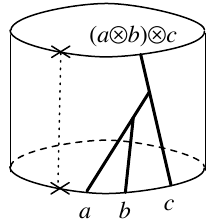
Figure 33 . The Hilbert space of a circle with multiple line operators are identi(cid:12)ed with the Hilbert space of a circle with the fused line operator.